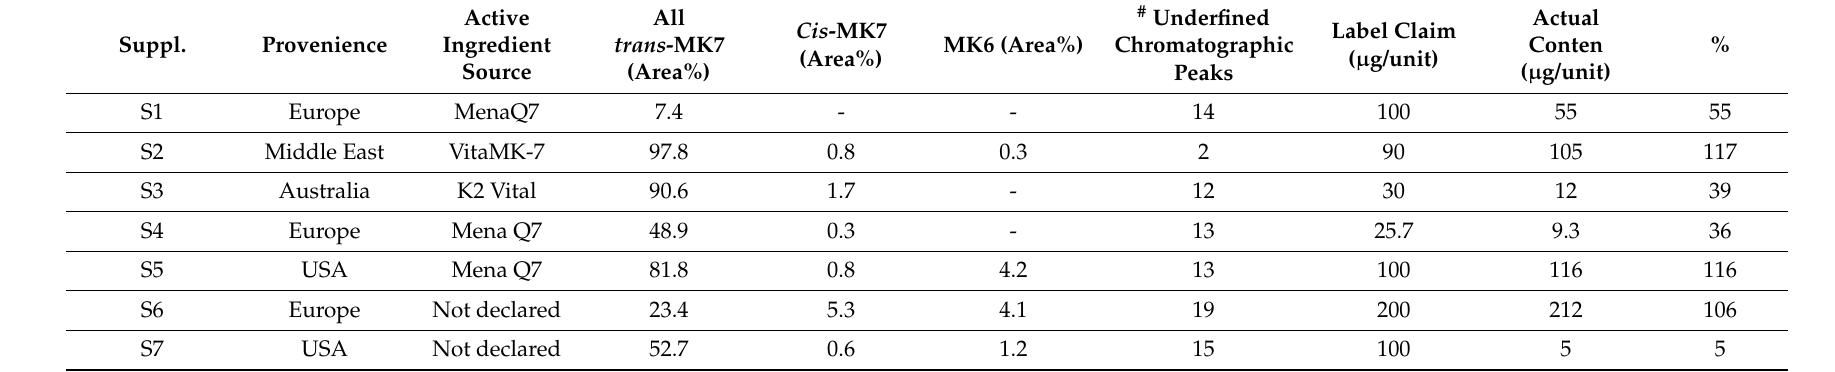
Table 2. Products assay and purity